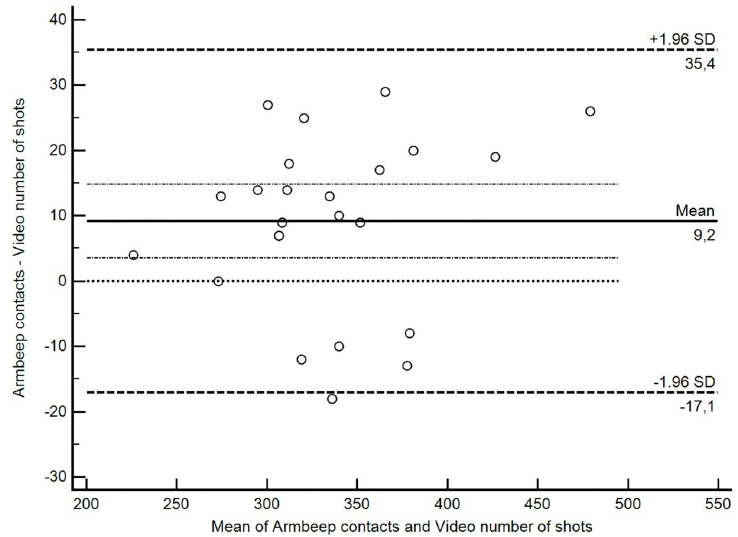
Fig 3. Bland Altman plot of the relationship between mean and difference between Armbeep sensor and video analysis.